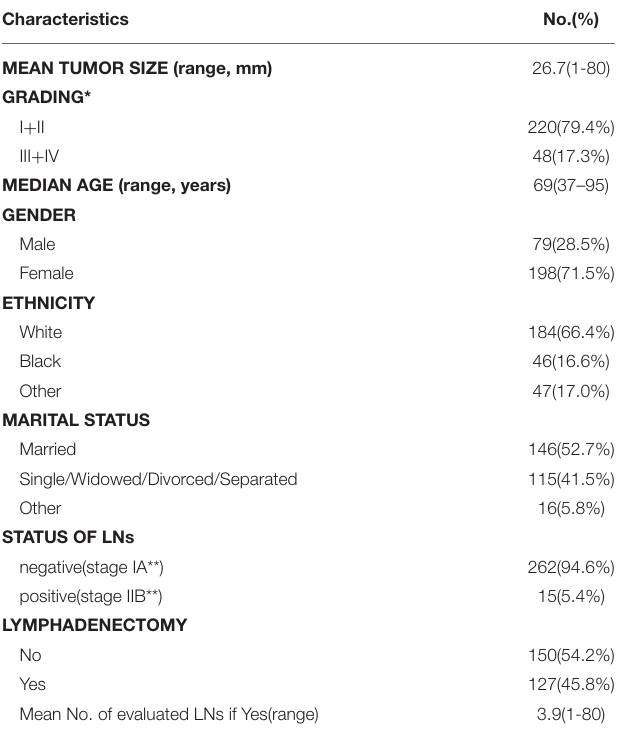
TABLE 1 | Demographic and tumor characteristics of GBA patients from the SEER database ( n = 277).